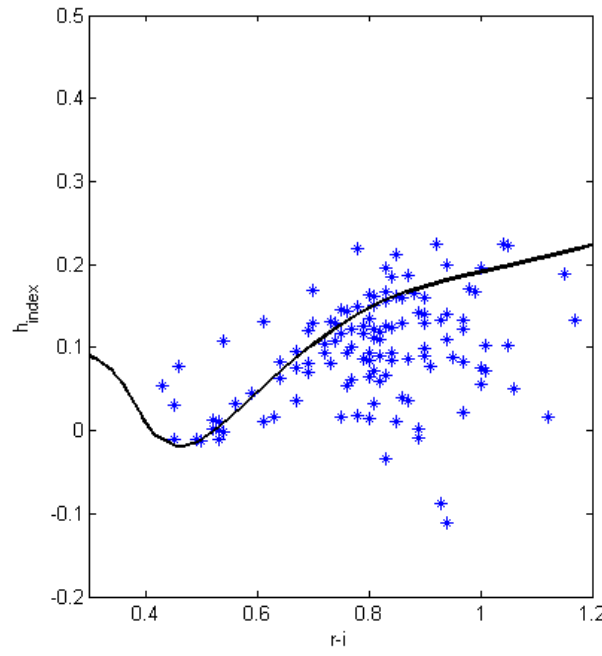
Fig. 1. The ( h index , r − i ) diagram for stars within 2 (cid:48) of the center of NGC 1857. The solid line shows the isochrone shifted by 0.43 mag along the abscissa. stars of spectral type A2 (McBride et al. 2008) and hence h index has a minimum